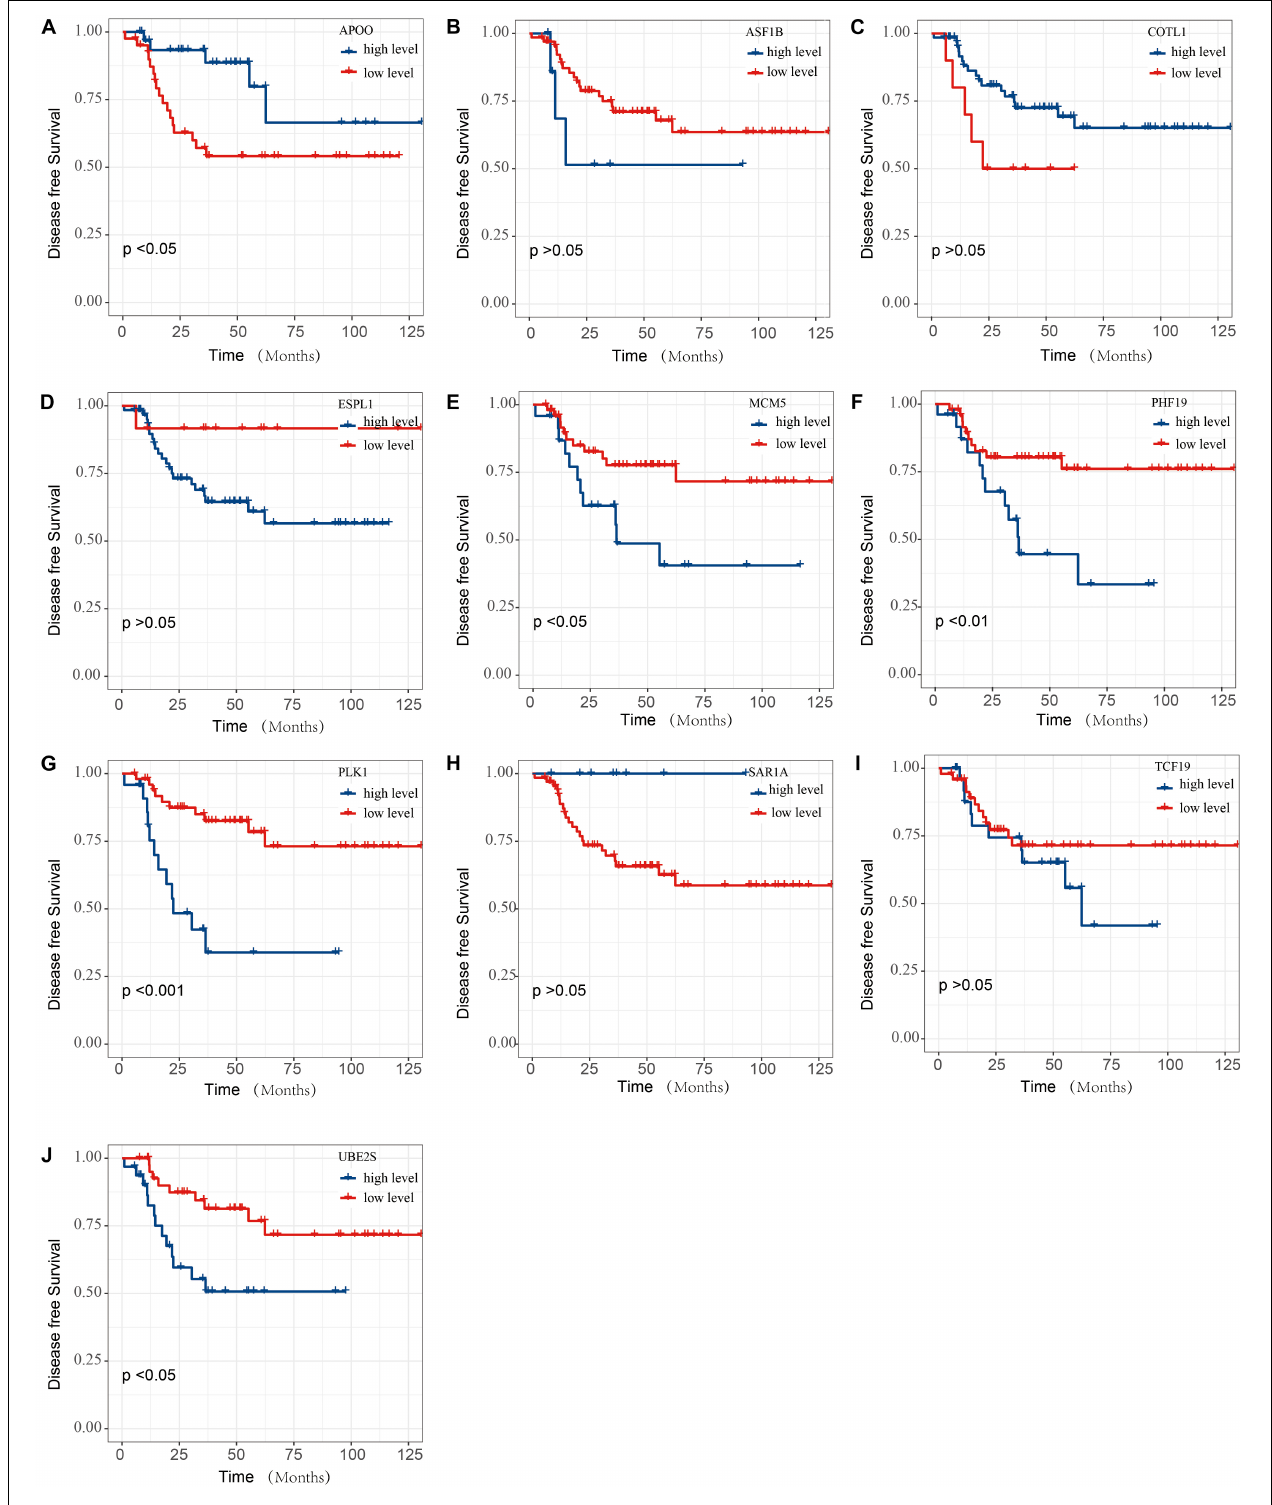
FIGURE 8 | The DFS of SAE1 coexpression genes for TNBC patients. The prognostic value of (A) APOO, (B) ASF1B, (C) COTL1, (D) ESPL1, (E) MCM5, (F) PHF19, (G) PLK1, (H) SAR1A, (I) TCF19, and (J) UBE2S mRNA expression for DFS in TNBC patients by Kaplan-Meier analysis. The log-rank test was performed to evaluate survival difference with the best cutoff